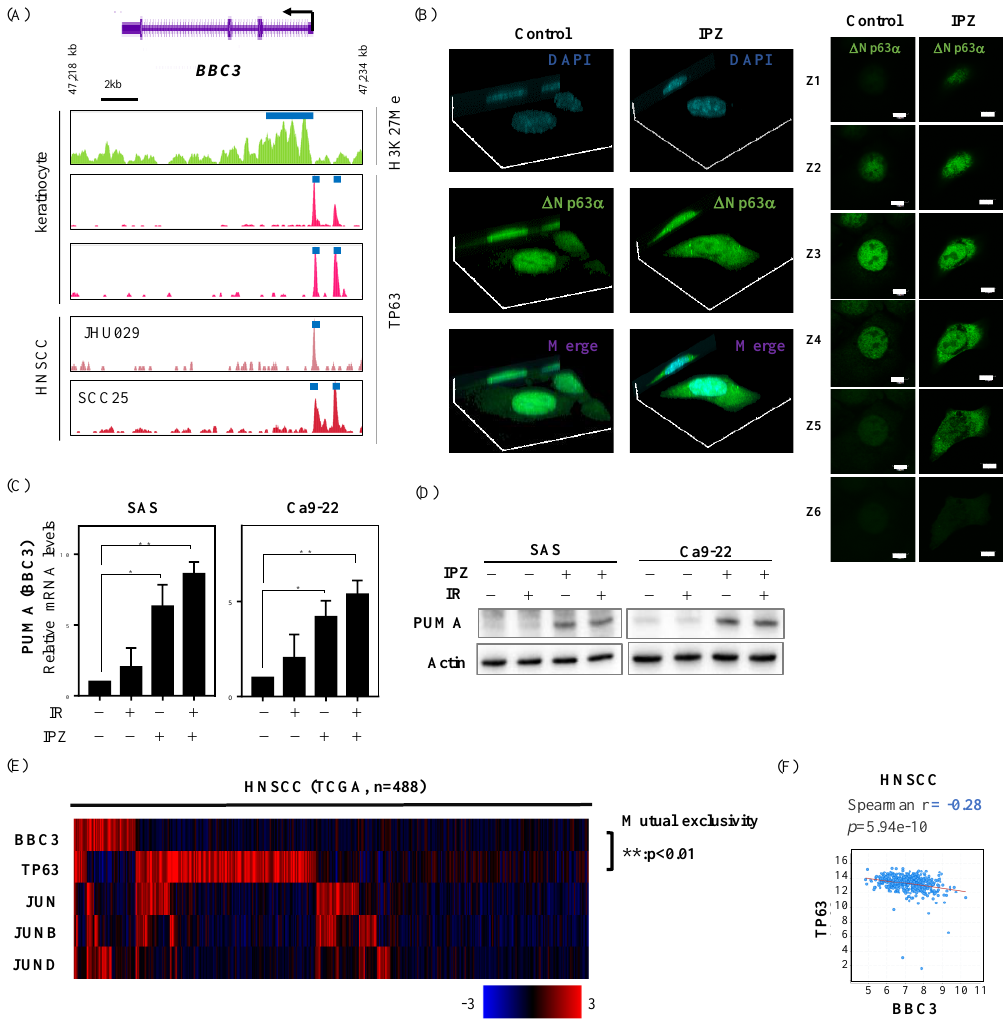
Figure 3. IPZ silences pro-apoptotic p53-upregulated modulator of apoptosis (PUMA) by suppressing the ∆ Np63a nuclear import in HNSCC cells. ( A ) The occupancy profiles of H3K27me and TP63 at the BBC3 (PUMA) promoter in keratinocytes and HNSCCs. ( B ) Confocal imaging of ∆ Np63 α in SAS cells. Three-dimensional construction with maximum intensity (Left), and sequential z-stack imaging (Right), respectively. ( C , D ) IPZ (10 µ M) was added to the culture medium 1 h before X-ray irradiation. After 20 h-incubation, the cells were harvested for qRT-PCR and Western blot analyses. ( C ) qRT-PCR analysis of PUMA expression levels. Data are presented as the mean ± SD of three independent experiments performed in triplicate. * p < 0.05, ** p < 0.01 versus DMSO control. ( D ) Western blot analysis of PUMA expression. The representative images are shown. ( E ) The heat map showing mutual exclusivity between BBC3 (PUMA) expression and TP63, as well as activator protein 1 (AP-1) family genes. The samples were divided according to mRNA expression levels (mRNA expression z-Scores (RNA-Seq V2 RSEM) > mean + 1.0 SD) from the TCGA cohorts. The P values are based on Fisher’s exact test. ( F ) The correlation between each BBC3 (PUMA) mRNA and TP63 mRNA in HNSCC from TCGA.